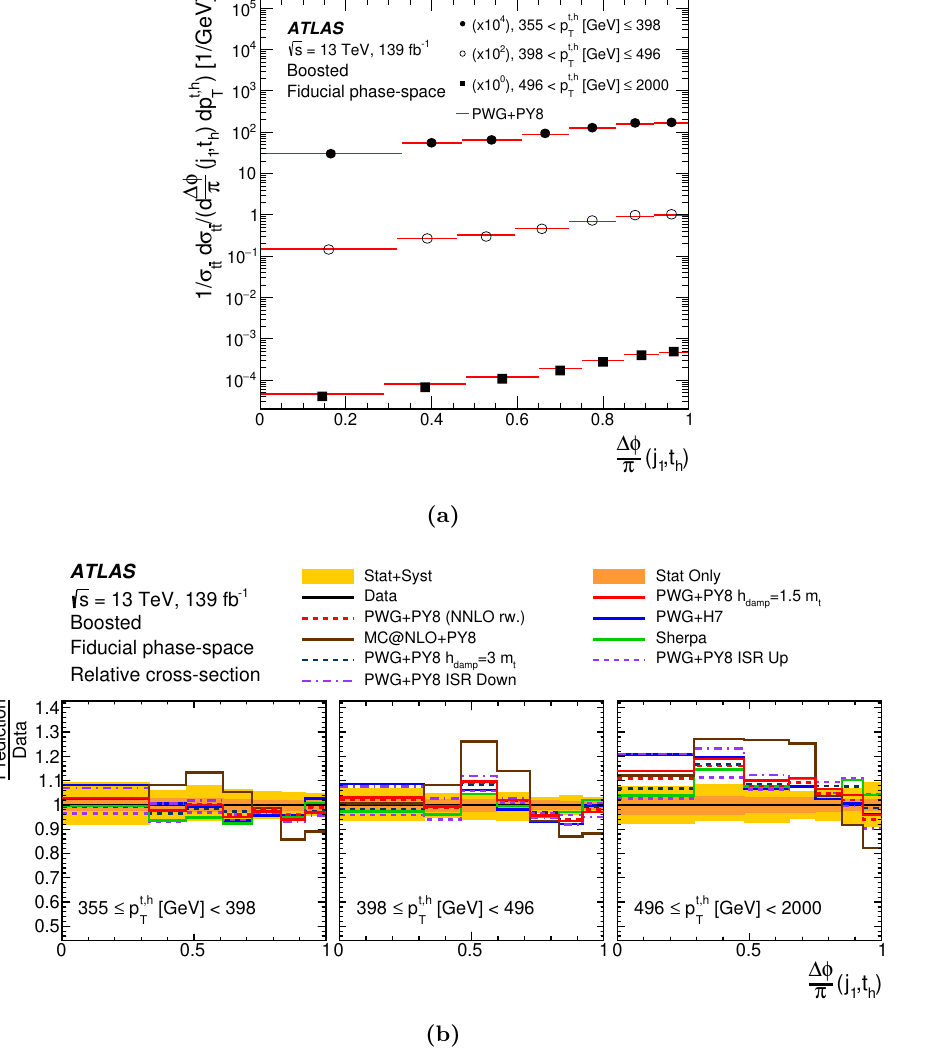
Figure 28. (a) Normalised differential cross-section measurements as a function of the ∆ φ an- gle between the leading additional jet and the hadronically decaying top quark in bins of p t,h are compared with the prediction from the Powheg+Pythia MC generator. The measurement and the predictions are further normalised by the factors shown in parentheses to aid visibility. (b) Ratio of the measured normalised cross-section to different NLO, and NLO reweighted to NNLO, predictions of t ¯ t signal for the same differential variables. PWG+PY8 corresponds to the Powheg+Pythia sample, PWG+H7 to the Powheg+Herwig sample and MCatNLO+PY8 to the MadGraph5_aMC@NLO+Pythia sample. The yellow band represents the total uncertainty of the measured differential cross-section while the orange band shows the statistical